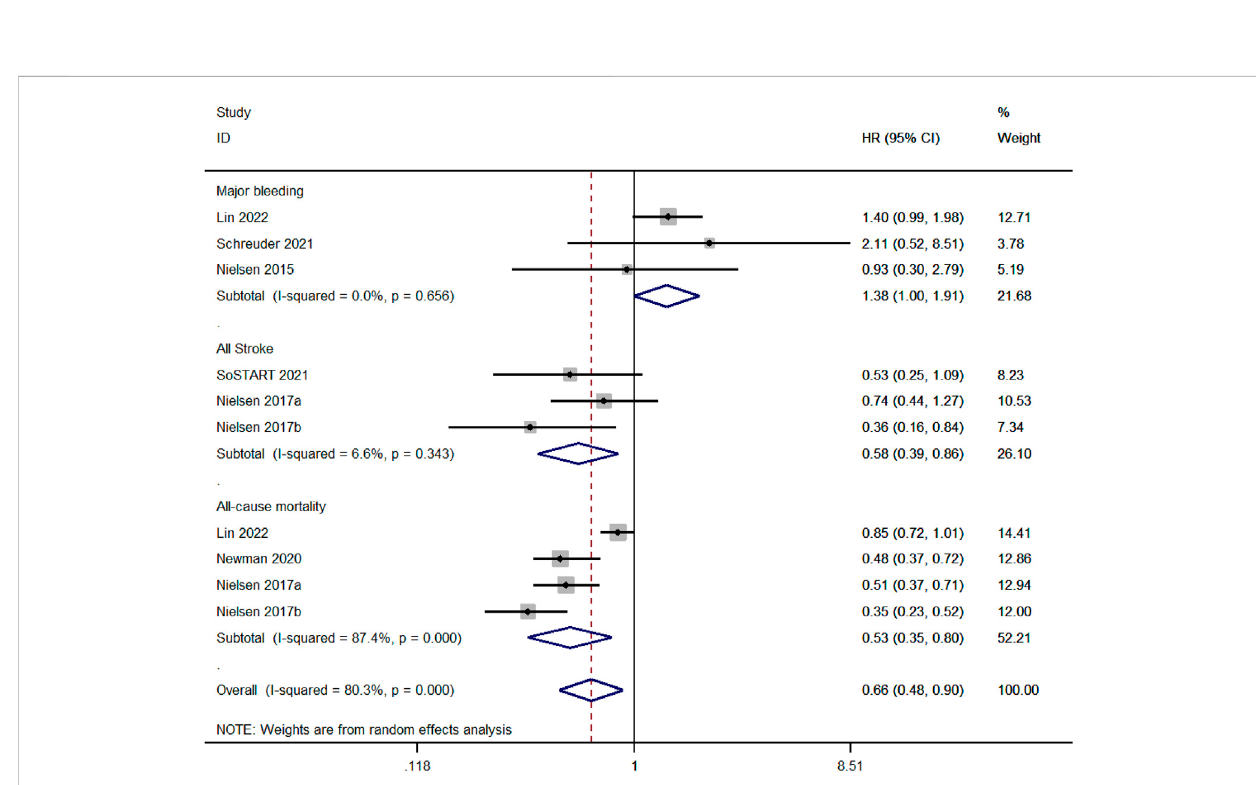
FIGURE 6 Meta-analysis of the risk of major bleeding in OAC versus